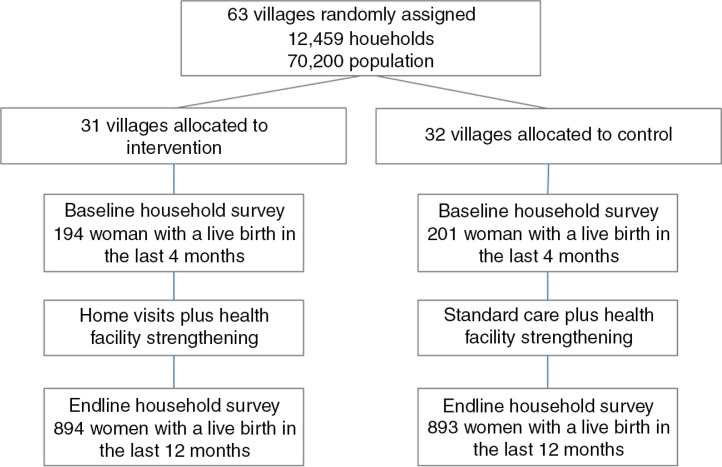
UNEST trial profile.